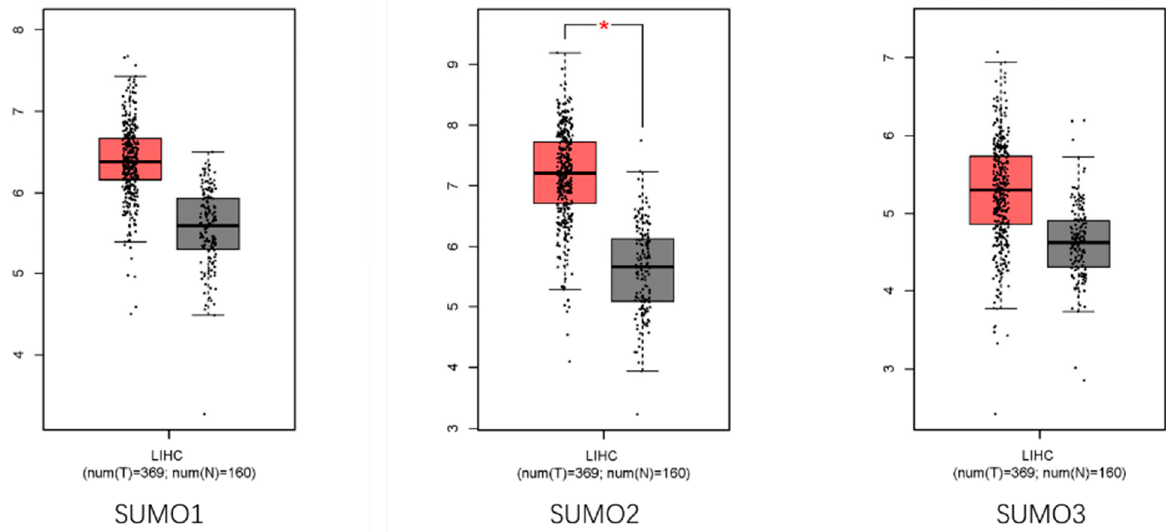
Figure 3. The expression differences of SUMOs mRNA in human HCC specimens. (* p < 0.01, The ordinate is the expression amount represented by log 2 (TPM + 1).).